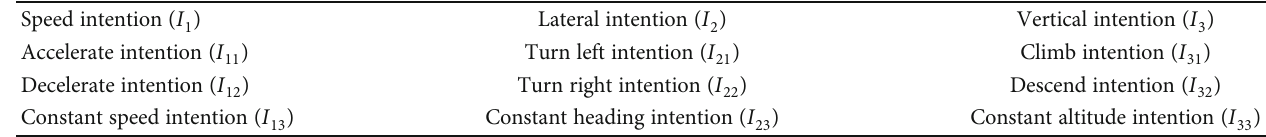
Table 1: Pilots ’ intention set.